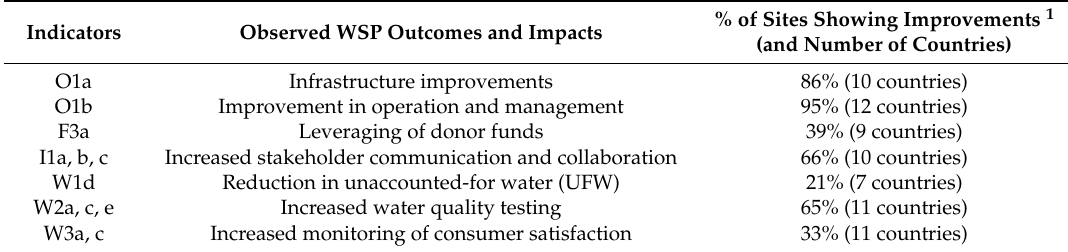
Table 4. Summary of observed WSP outcomes and